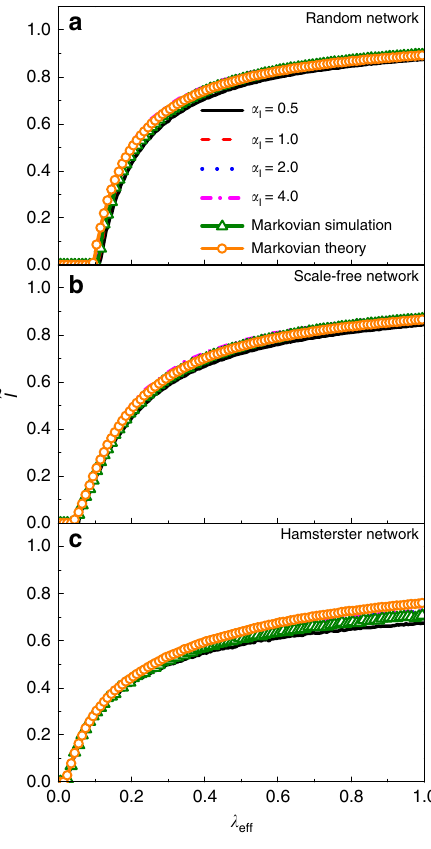
Fig. 4 Demonstration of equivalence. Comparison of stationary infected density with type-II activation mechanism between non-Markovian and Markovian processes for a random b scale-free, and c Hamsterster networks which are the same as the networks in Fig. 3. Solid, dashed, dotted, and dot-dashed curves represent the results for α I = 0.5, 1, 2, 4, respectively, and the triangles and circles correspond to simulation results from the Markovian process and the analytical solutions, respectively. Other parameters are α R = 2 and β R =